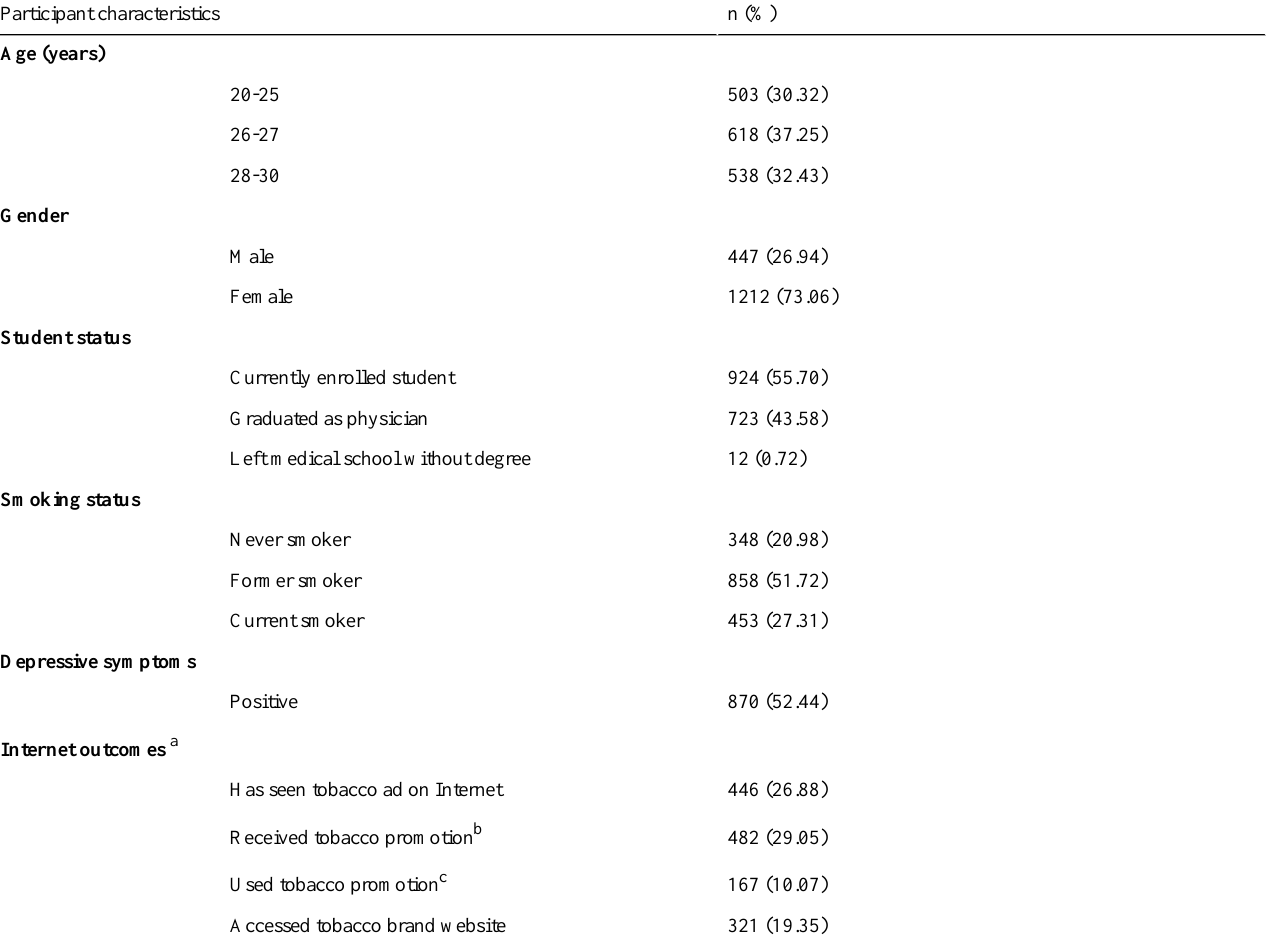
Table 1. Smoking behavior and exposure to tobacco marketing among current and recent medical students (n=1659), Buenos Aires, Argentina, 2011.